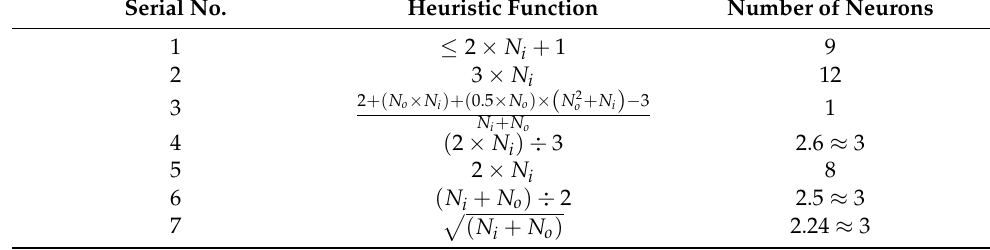
Table 3. The heuristic function to determine number of neurons (functions adopted from [39]). Serial No. Heuristic Function